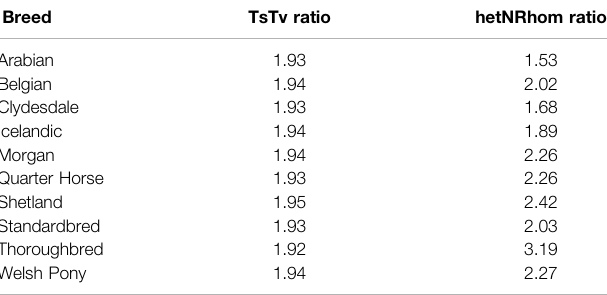
TABLE 3 | Estimated marginal mean of the transition to transversion (TsTv) and heterozygous to non-reference homozygous (hetNRhom) ratios accounting for depth of coverage.